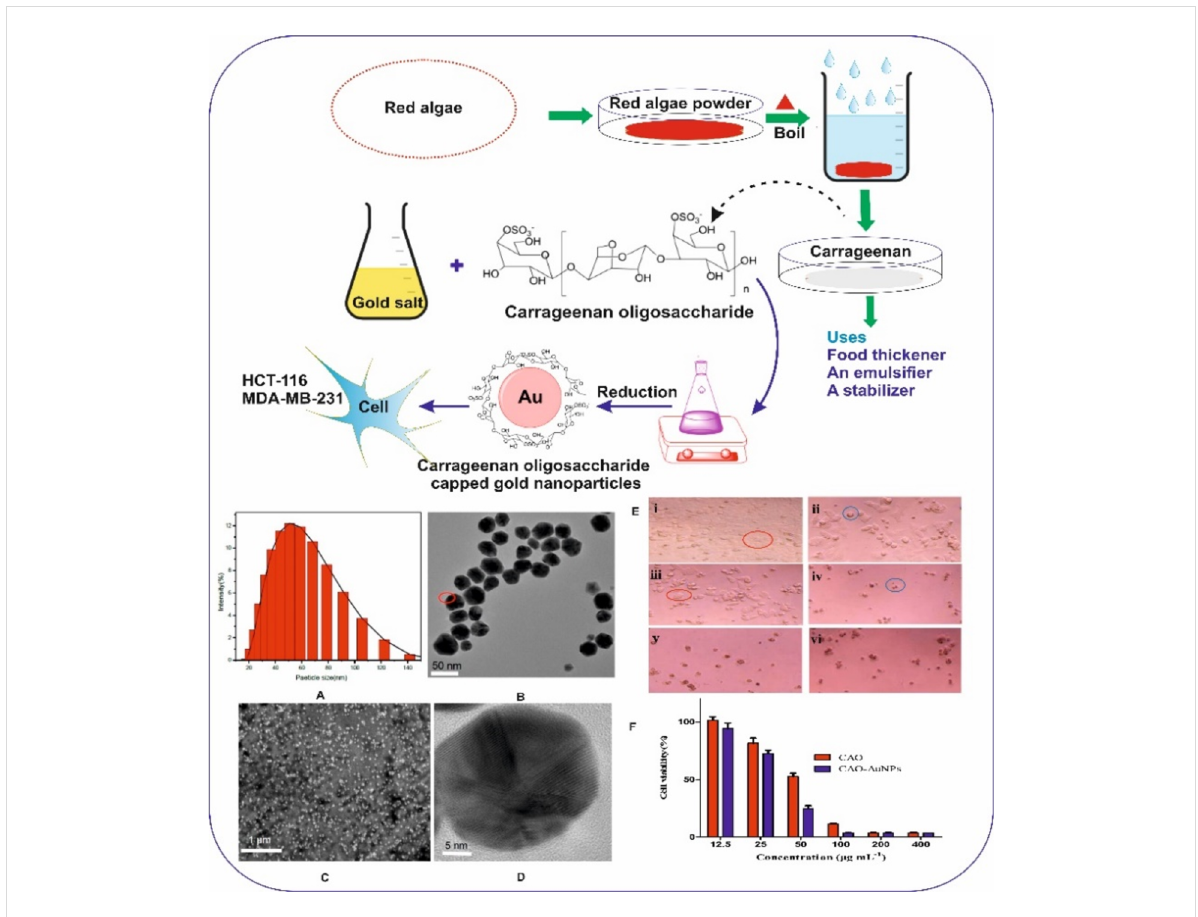
Figure 5: Carrageenan as capping and reducing agent for gold nanoparticle synthesis. (A) Histogram for the size distribution of nanoparticles. (B), (C) and (D) show TEM micrographs of the nanoparticles at different magnifications. (E) and (F) show the antitumor activity against MDA-MB-231 and HCT-116. Adapted from [32], © 2018 X. Chen et al., distributed under the terms of the Creative Commons Attribution 4.0 International Licence, http://